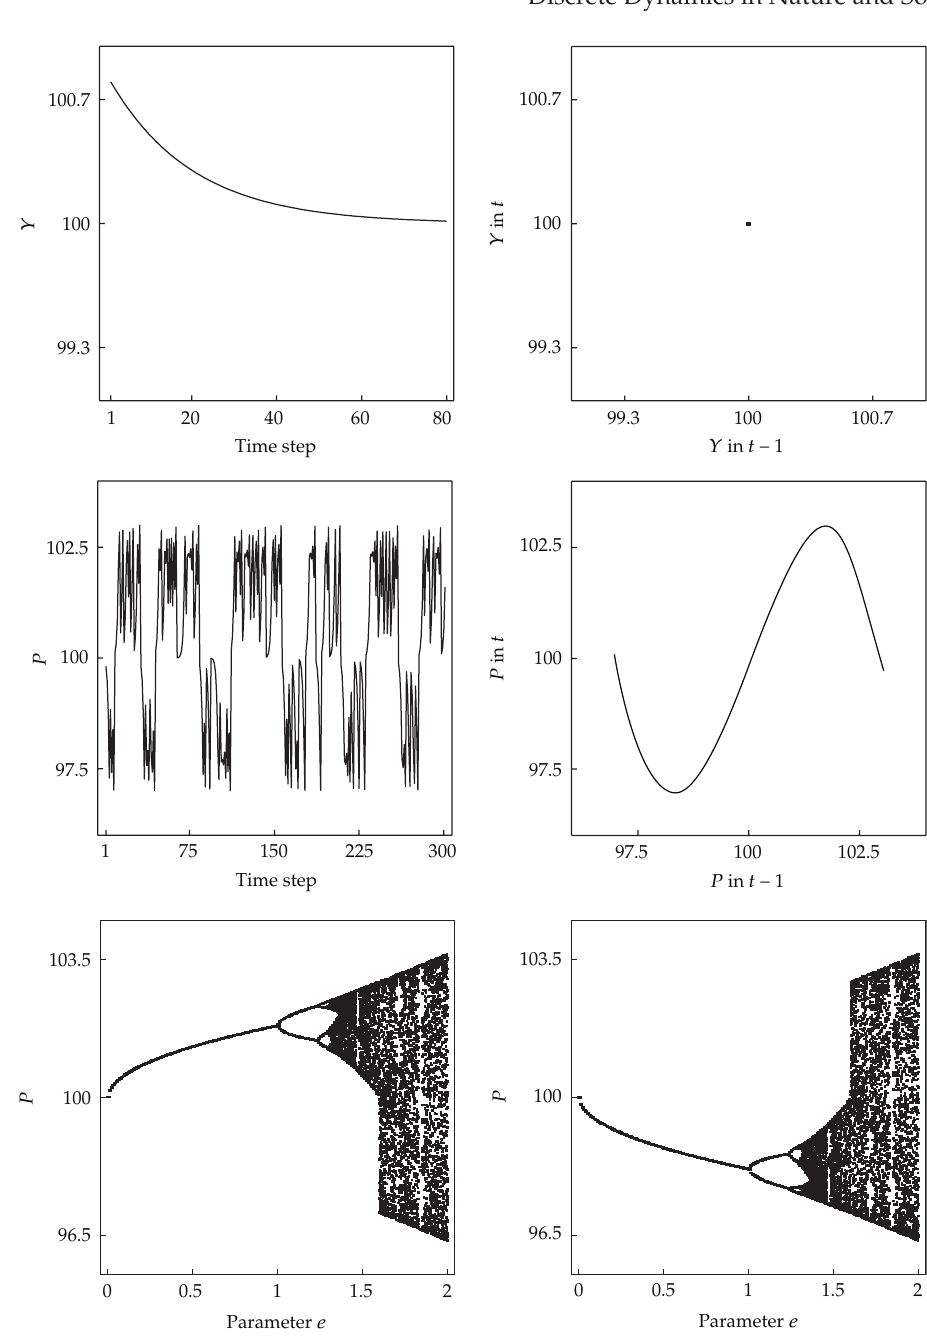
Figure 1: The dynamics of isolated goods and stock markets. Parameter setting as in Section 4. Bifurcation parameters as indicated on the